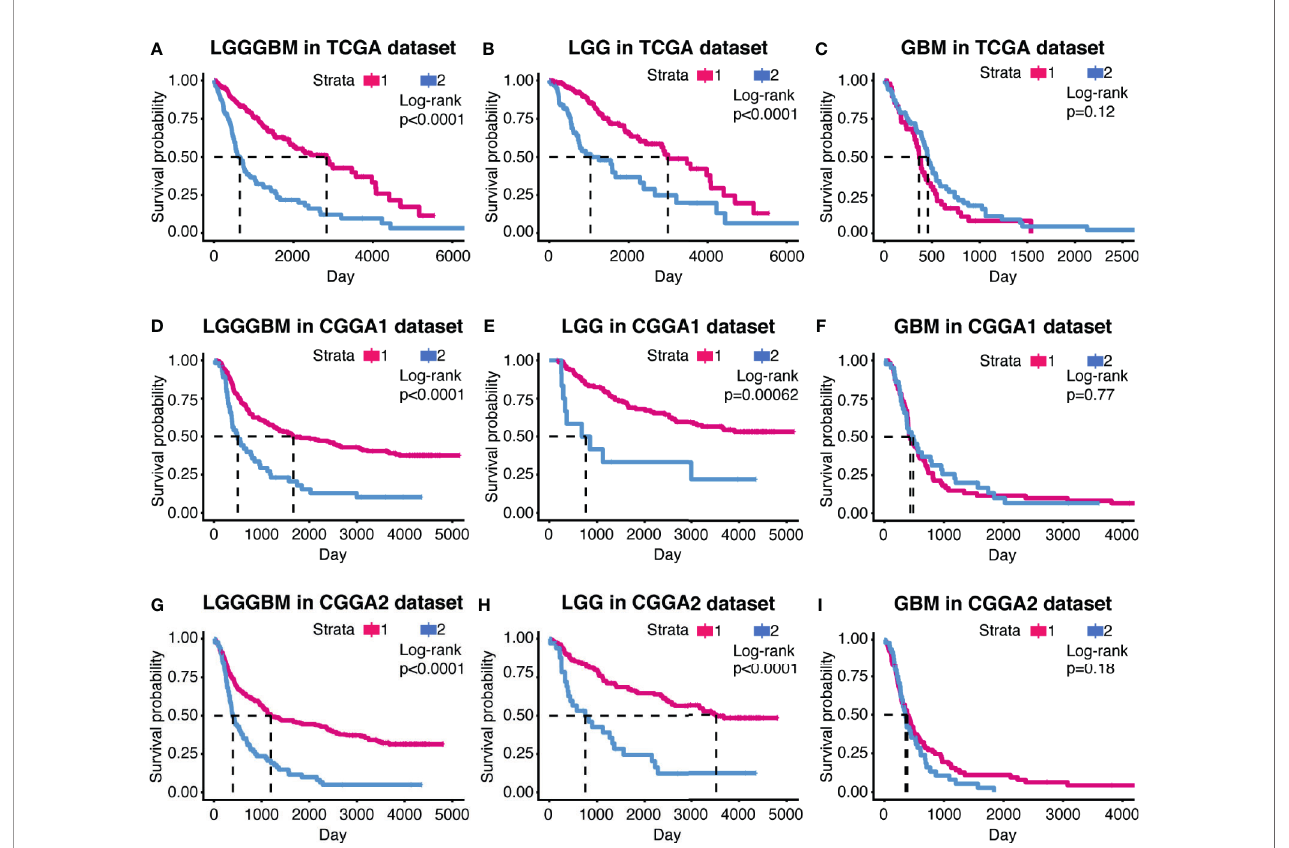
FIGURE 2 | The prognostic value of the cluster model in gliomas. Kaplan – Meier survival analysis were used to show overall survival outcome difference between the two clusters in LGG, GBM, and LGGGBM samples from TCGA (A – C) , CGGA1 (D – F) , and CGGA2 (G – I)